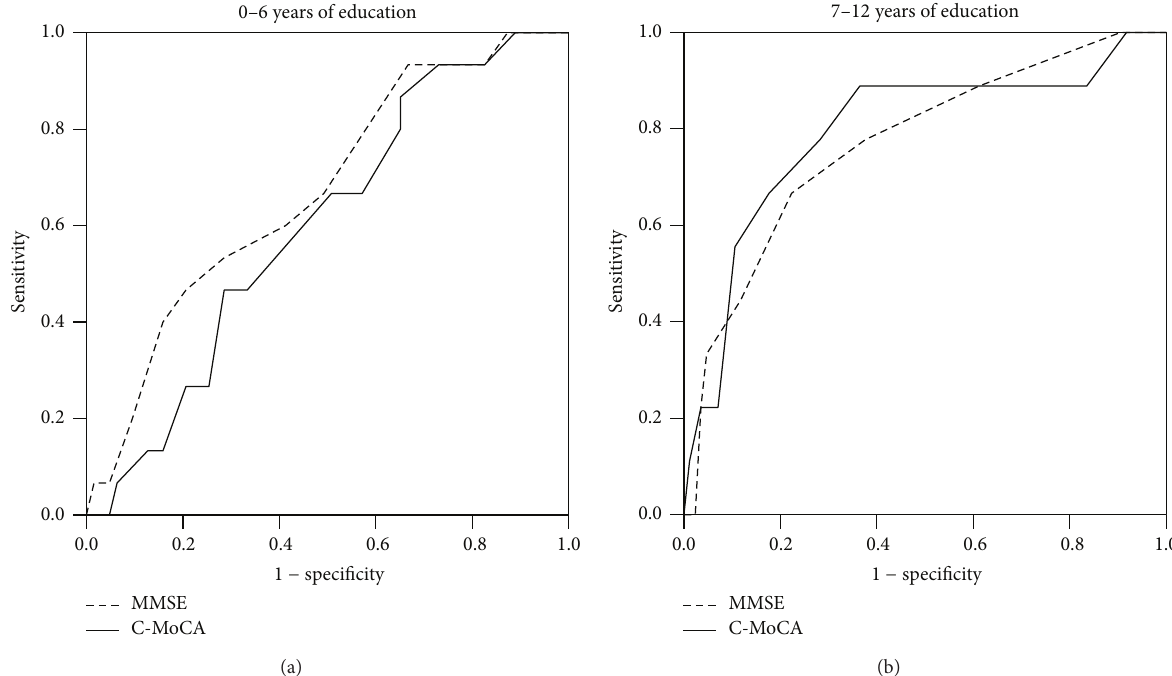
Figure 2: Receiver operating characteristic curve of MMSE and C-MoCA in different education groups. The ROC curves were used to detect the amnesic MCI for different education groups: (a) for 0–6 years of education group and (b) for 7–12 years of education group. C-MoCA: the Chinese version of Montreal cognitive assessment. MMSE: mini-mental state examination.